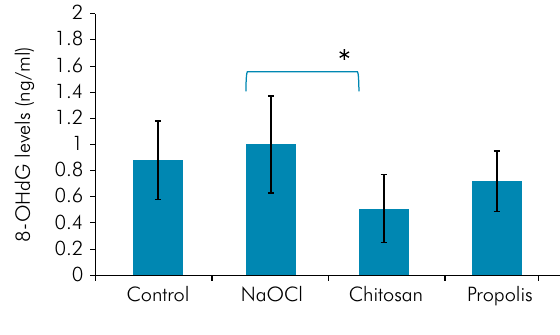
Figure 1. The level of 8-OHdG released after the application of the groups of solutions. Values represent mean and SD of three independent experiments. p < 0.05; *Statistically significant differences between groups.